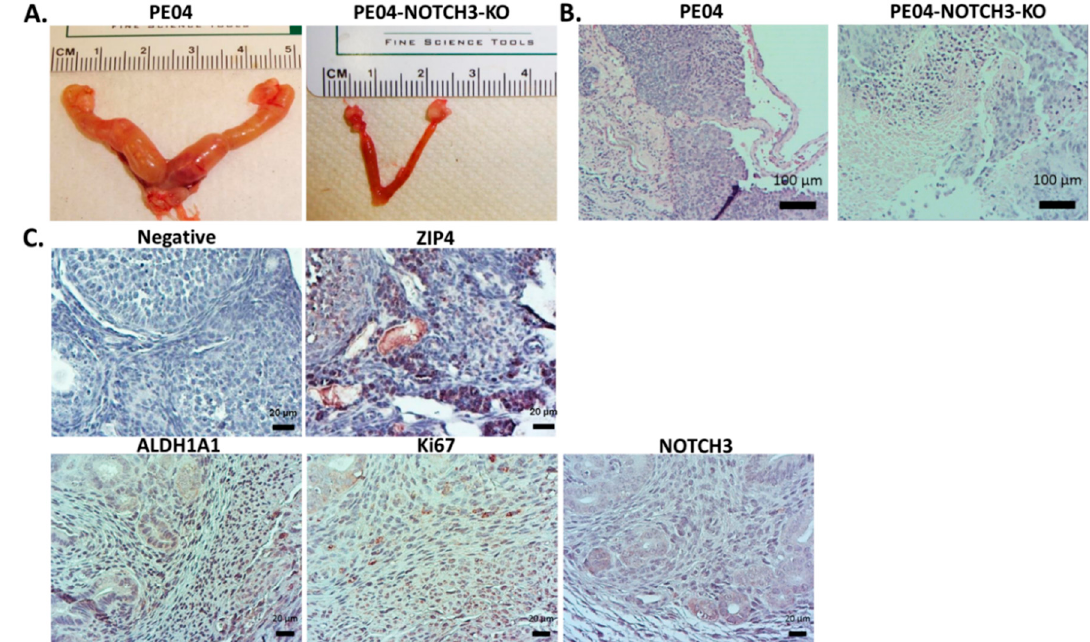
Figure 7. NOTCH3 knockout reduced tumorigenesis in NSG mice. ( A ) Representative tumors formed in PE04 vs. PE04-NOTCH3-KO injected mice. ( B ) Representative H&E staining of tumors formed in PE04 and PE04-NOTCH3-KO injected NSG mice. ( C ) Representative IHC staining for ZIP4, ALDH1A1, Ki67, and NOTCH3 in NOTCH3-KO tumor section. Samples without the first antibody were used as negative staining controls. The dark purple / brown or dark blue colored cells above the background are positive stained.